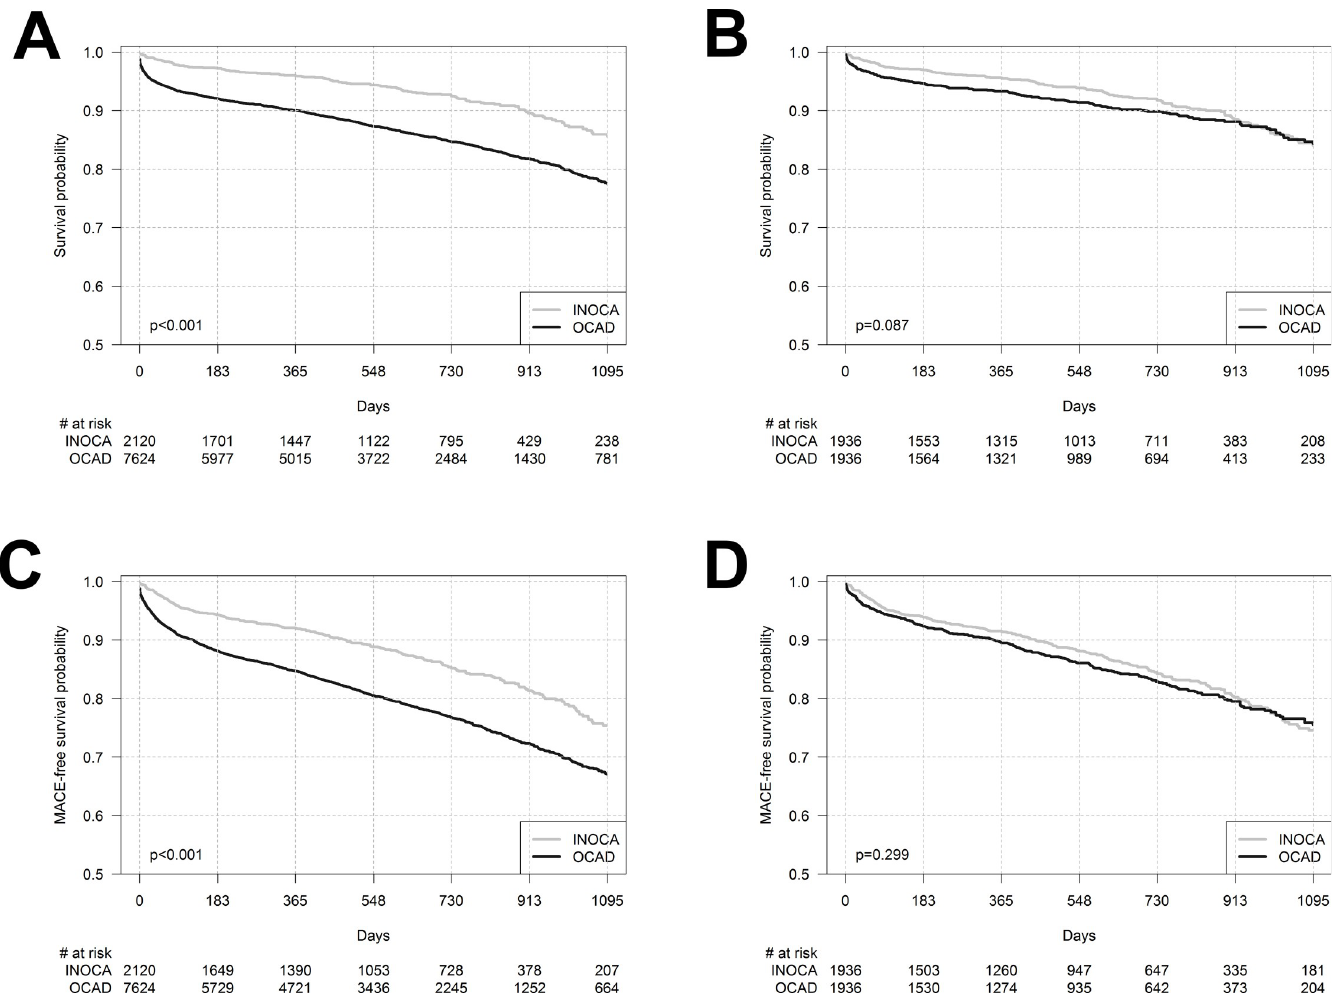
Fig 1. Kaplan-Maier curves for the following. A, days-to-death in unadjusted cohorts of patients with ACS INOCA and those with ACS OCAD. B, days-to-MACE (death, cardiac arrest, MI, stroke, and HF hospitalization) in unadjusted cohorts of these patients. C, day-to-death in propensity score matched cohorts of these patients. D, days-to-MACE (death, cardiac arrest, MI, stroke, and HF hospitalization) in propensity score matched cohorts of these patients. ACS, acute coronary syndrome; INOCA, myocardial ischemia with no obstructive coronary arteries; OCAD, obstructive coronary artery disease; MI, myocardial infarction; HF, heart failure.